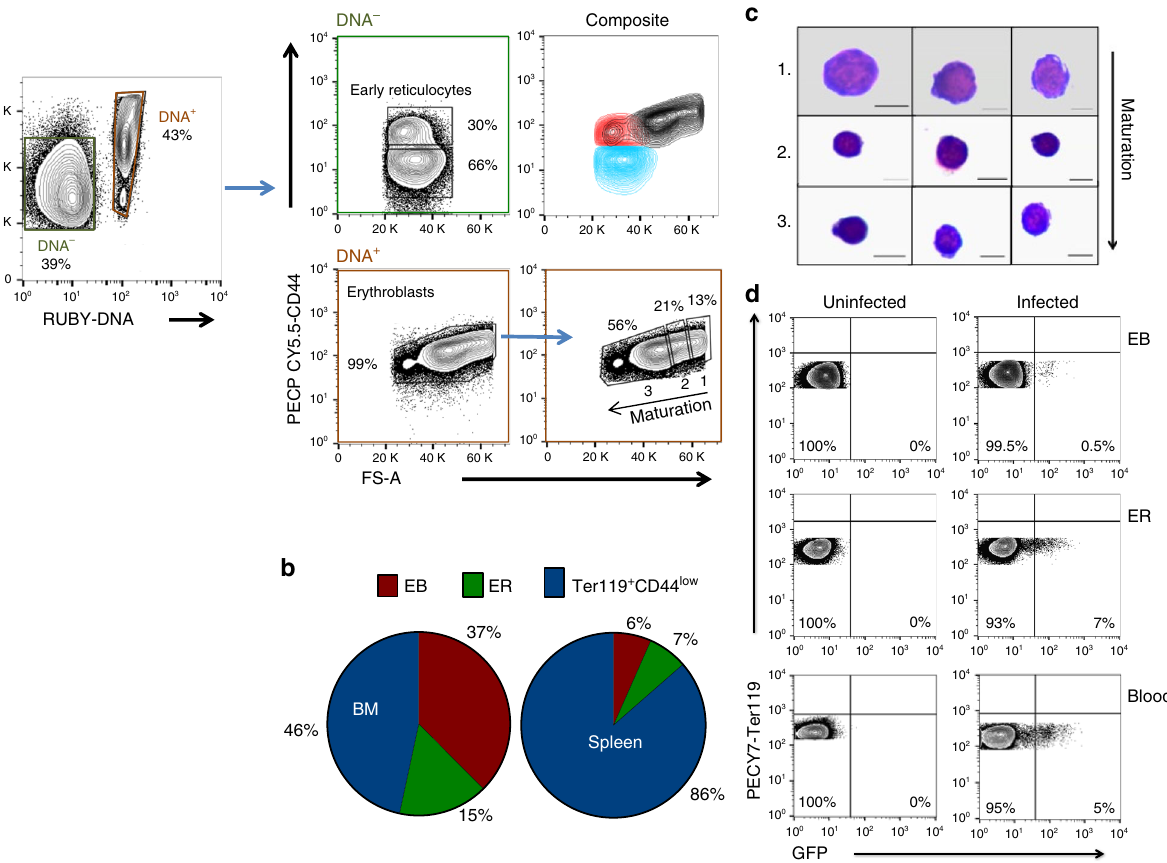
Fig. 1 Flow analysis robustly detects P. berghei GFP -infected, Ter119 + CD44 high erythroid cells. a Representative FACS gating strategy for bone marrow (BM) and splenic resident erythroid precursors in uninfected and P. berghei -infected animals. DNA − and DNA + erythroid cells were gated against CD44 and FS- A to resolve CD44 high early reticulocytes (ER) cells and erythroblasts (EB), respectively. The DNA − Ter119 + CD44 low gate was de fi ned by the CD44 expression of erythroid cells within peripheral blood. The EB were gated in a 1:2:4 ratios to resolve immature, intermediate and mature stages, labelled 1, 2 and 3, respectively. Overlaying the DNA − and DNA + populations (composite; top right hand side of quadrant) reveals an overlap in early reticulocyte and erythroblast size. b To con fi rm erythroblast gates contained purely nucleated cells, populations were sorted from gates 1 – 3, stained with May-Grunwald and examined by light microscopy. Three representative cells from each group from different sorts are shown. Scale bar: 6 μ m. c Average percentage contribution of EB, ER and Ter119 + CD44 low cells to the total Ter119 + cell population in the BM and spleen of BALB/c mice. d Identi fi cation of GFP expressing P. berghei parasites (PBGFP con ) in populations of EB, ER and peripheral blood erythrocytes (P) gated according to the developed